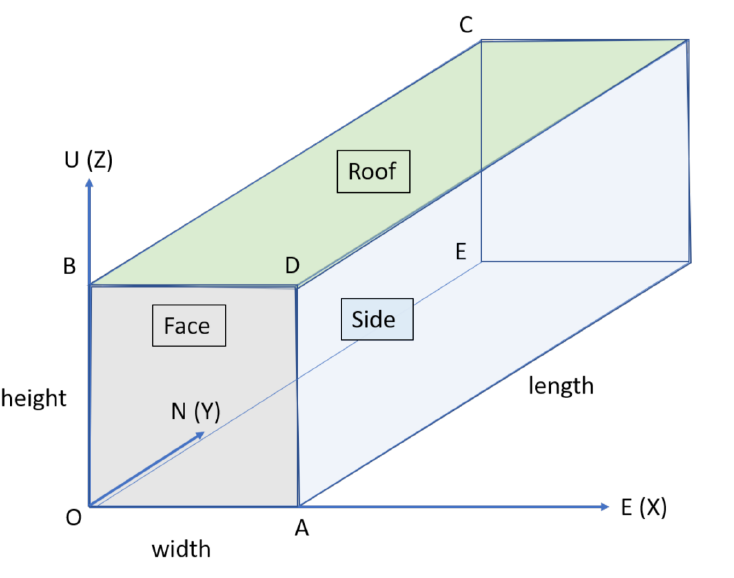
Figure 5. Cold storage container orientation